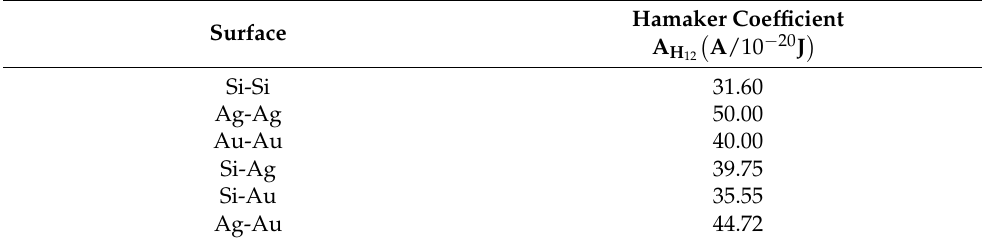
Table 3. Hamaker coefficient of the surfaces [41].